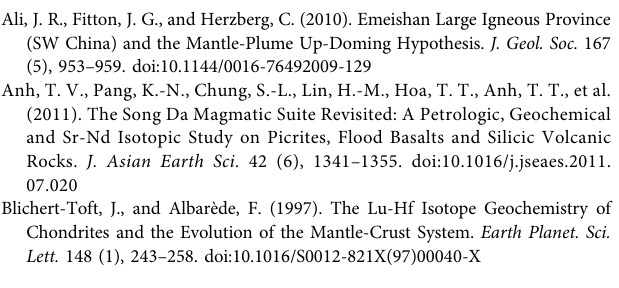
Frontiers in Earth Science |